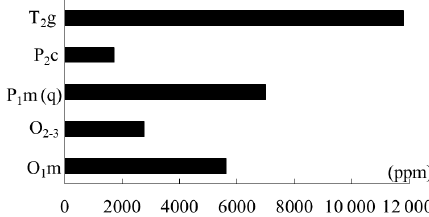
Figure 9. The evaluation of the decreased CO 2 concentration caused by carbonate corrosion based on stratigraphic